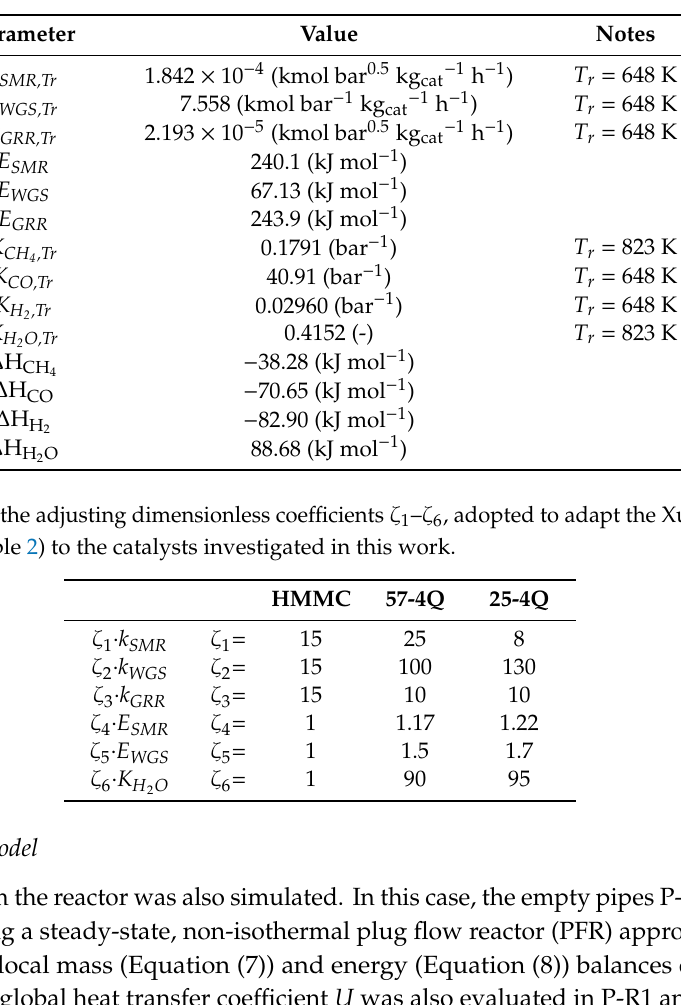
Table 2. Kinetic parameters, from Xu and Froment [5].